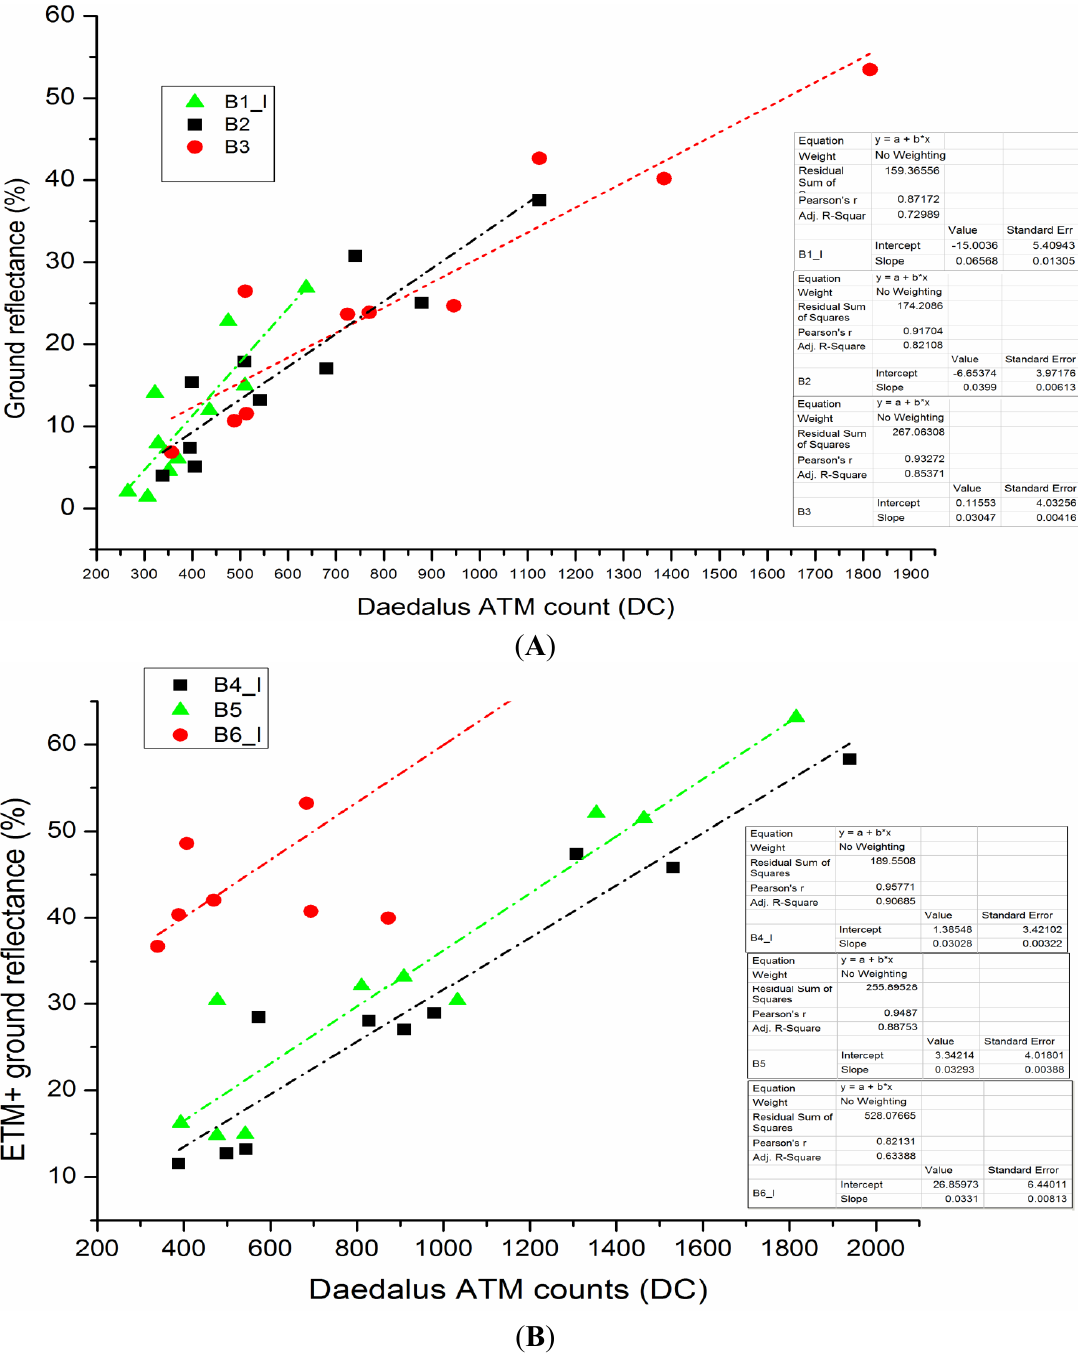
Figure 5. Regression models for Daedalus ATM reflectance ground retrieval through ELM method from ETM+ atmospherically corrected ground reflectance data for bands 1–3 ( A ) and bands 4–6 ( B ). Here BX state for the related Daedalus spectral band while the I suffix means interpolated